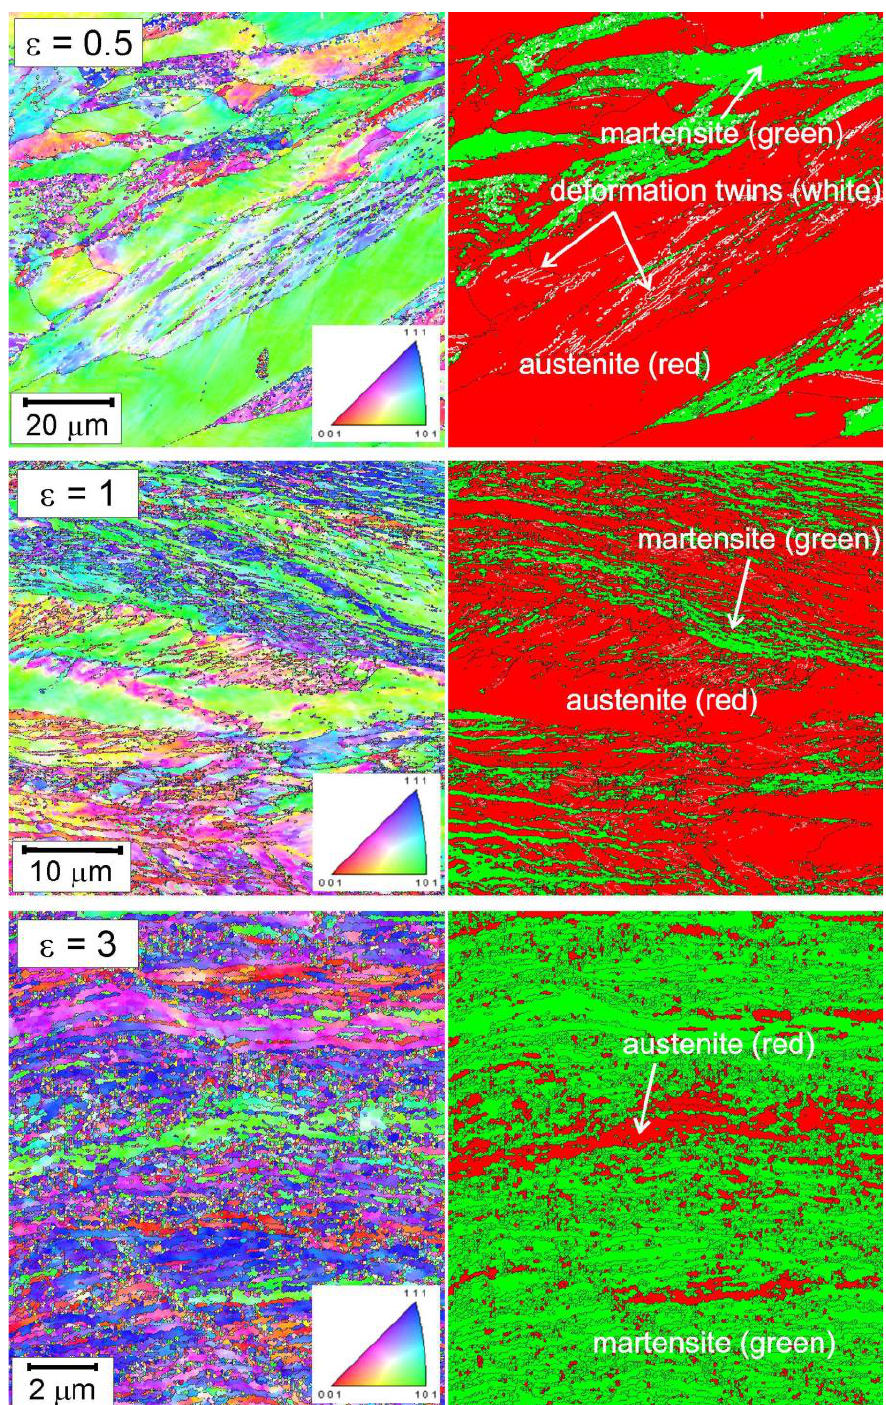
Figure 15. Deformation microstructures in a 304L stainless steel after cold rolling to the indicated total strains. The colors in the left images correspond to the crystallographic orientations along the normal direction (vertical in the images); those in the right images show the phase distribution.